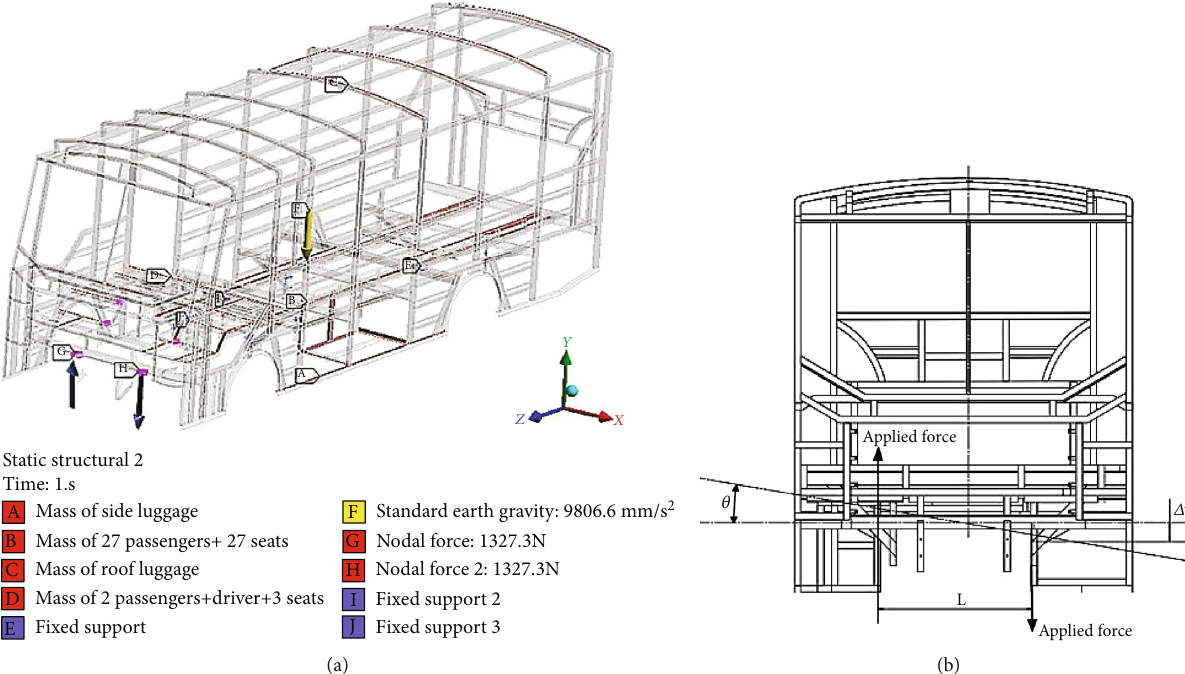
Figure 6: Loading and boundary condition: (a) pure torsional loading and boundary condition and (b) applied torsional force at a front view. Pillar-A (L-angle)